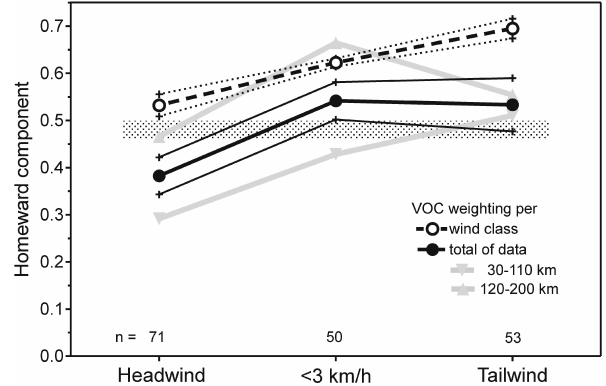
Fig. 6. Dependence of homeward orientation on direction of current wind. Black: means ( ± 99% confidence limits) of uppermost 10 of 100 homeward components c H obtained with air data collected at all 96 sites with winds blowing more or less homewards or away from home. The broken-line results were achieved with separate optimi- sations per current wind condition starting with standardised VOC weights around 1. The solid-line calculations used VOC weightings achieved with the total data set ranging from 30 to 200km and now applied to the respective wind condition. Sample sizes n of actually usable CGMs are given on the bottom. The dotted area indicates the c H range of the uppermost 10% summarising data of all wind con- ditions together. Grey: solid-line results subdivided into two classes of distance from the